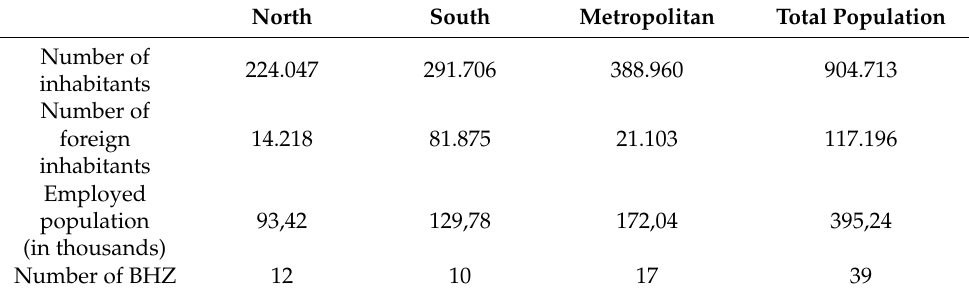
Table 1. Inhabitants according to the area of the island, taking into account foreign population (ISTAC 2018), employed population (ISTAC 2020) and BHZ (https://www3.gobiernodecanarias.org/ sanidad/scs/mapa) (accessed on 26 May